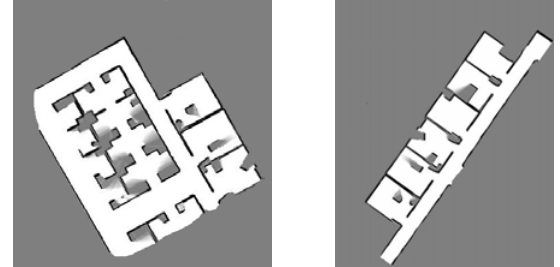
Fig. 2. Maps used for experiments – map 1 (left) and map 2